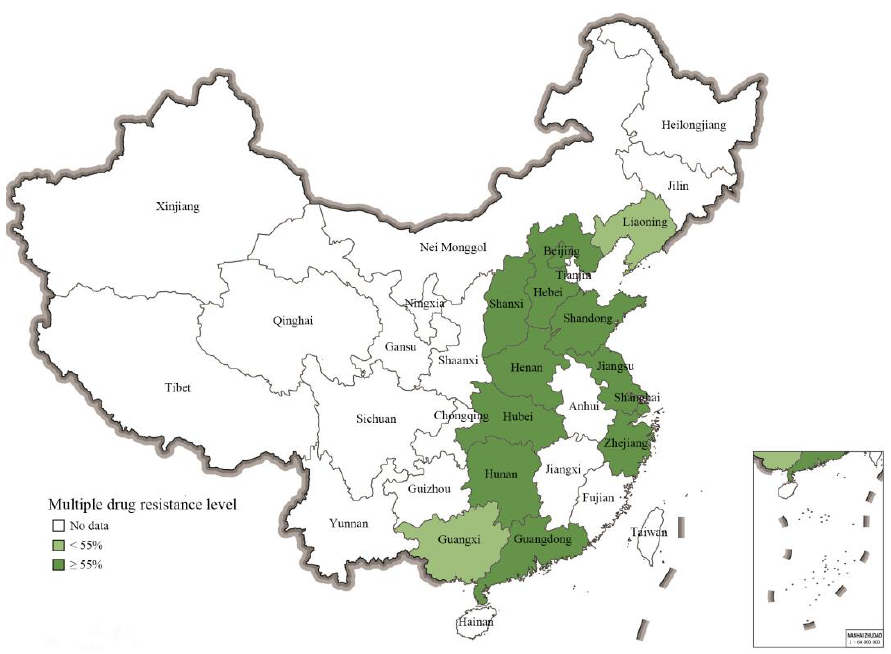
Figure 4. The pooled prevalence rates of MDR S . 1,4,[5],12:i:- in 13 Chinese provincial regions based on the eligible studies.